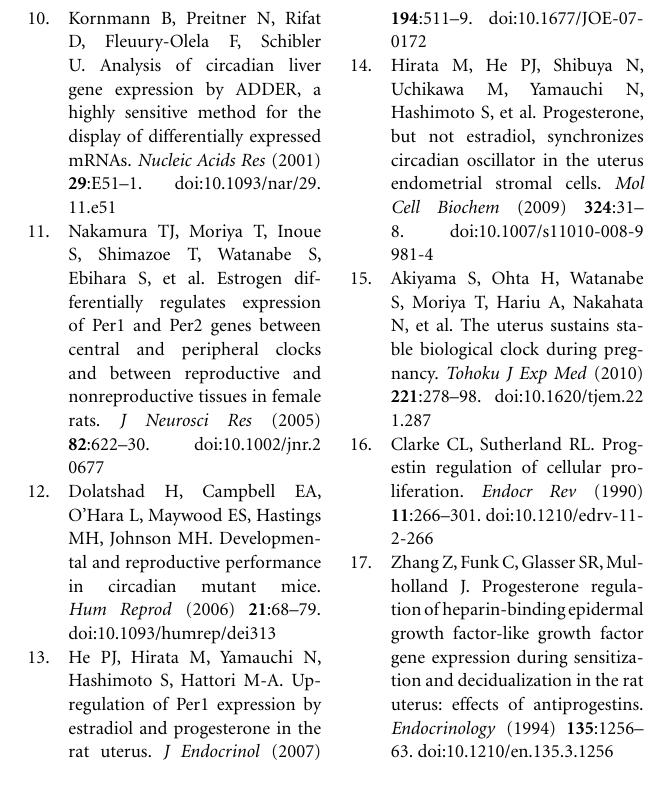
Figure S1 | Clustering of clock genes on the microarray results. The expression profiles of clock genes ( closed circle ) were divided into four groups (1 − 4). Red , relatively high expression; green , relatively low expression. Figure S2 | Clustering of implantation-related genes on the microarray results. Genes showing with significant alterations ( p < 0.05) are listed. Red , relatively high expression; green , relatively low expression. Figure S3 | Clustering of placenta formation-related genes on the microarray results. Genes showing with significant alterations ( p < 0.05) are listed. Red , relatively high expression; green , relatively low